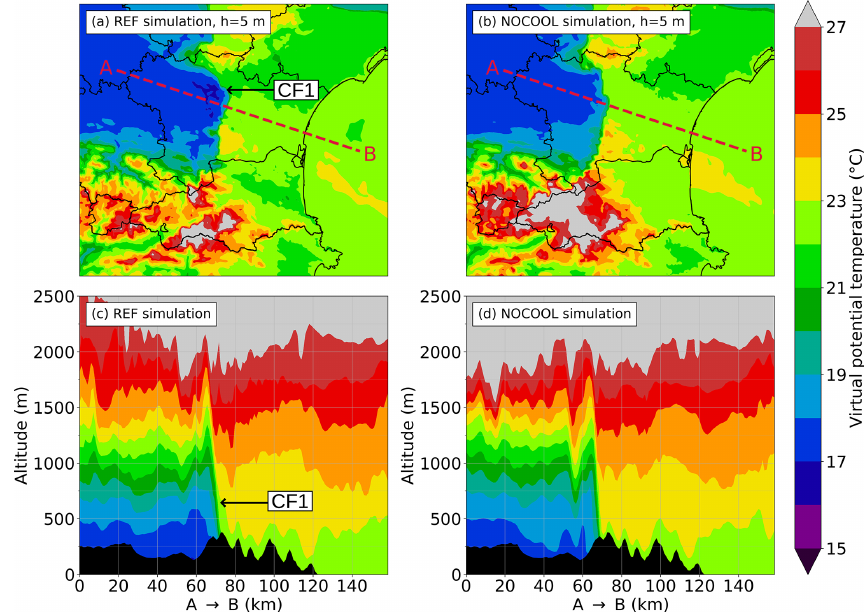
Figure 16. Virtual potential temperature at 5m height for the (a) REF and (b) NOCOOL simulations at 04:00UTC on 15 October. Vertical cross-sections of virtual potential temperature along the A–B axis are drawn for the (c) REF and (d) NOCOOL